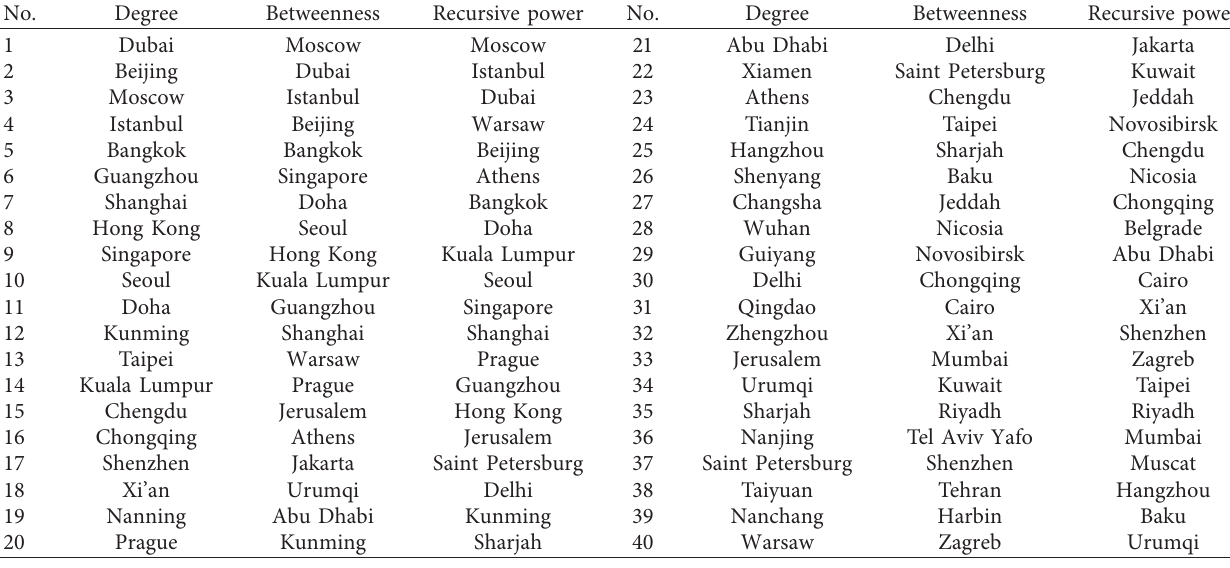
Table 2: Cities listed by centrality in B&R